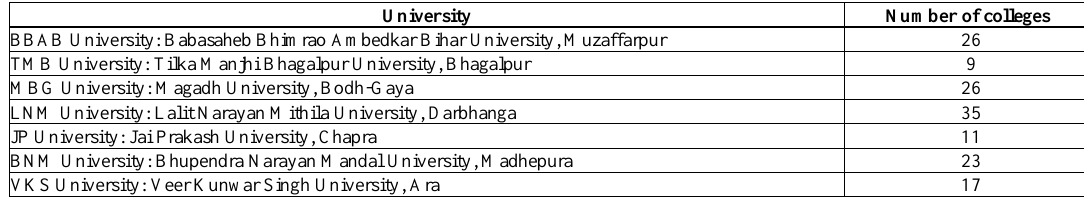
Table 1. Seven state public universities and the number of colleges considered for the study.